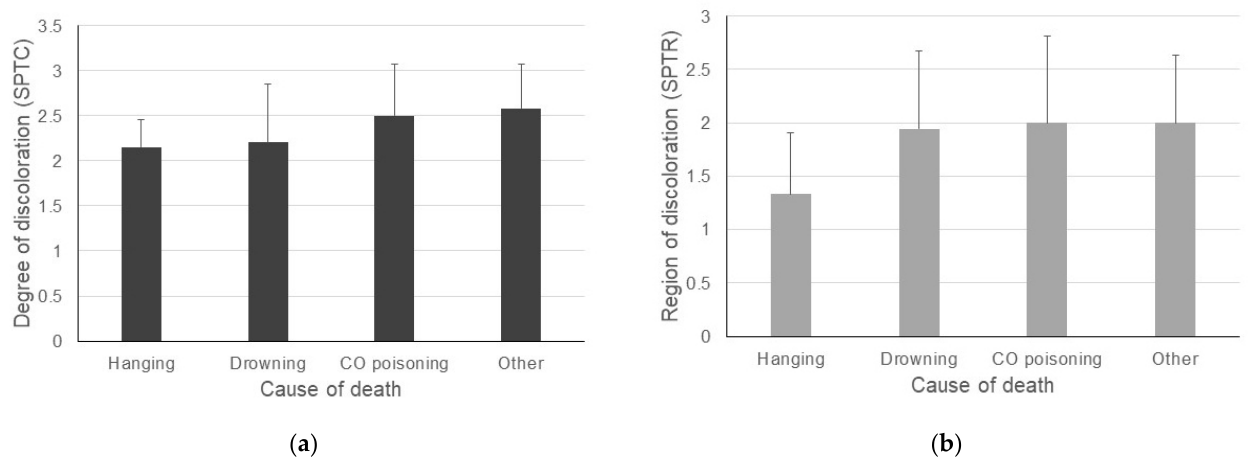
Figure 5. Association of SPTC ( a ) and SPTR ( b ) with cause of death (31 cases, n = 3–18). There were no significant differences for either score. SPTC, Score of Pink Teeth Color; SPTR, Score of Pink Teeth Region.